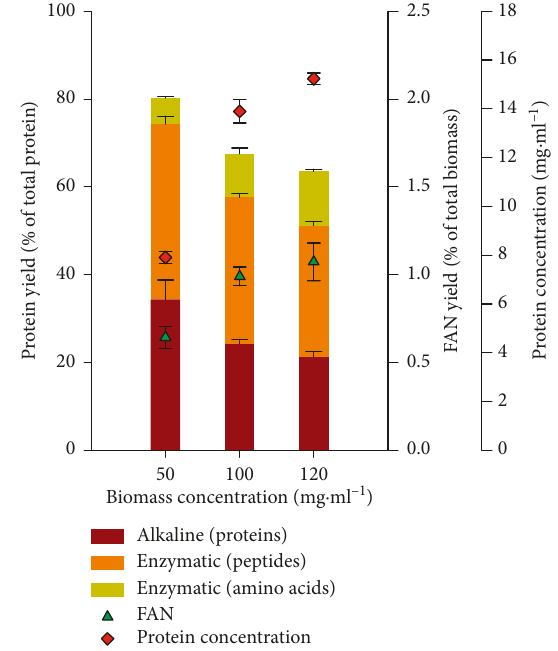
Figure 4: Effect of three biomass concentrations on the extraction yields of protein (% of total protein) and FAN (% of total biomass) and on the protein concentration in the final extract (mg differencing among first alkaline and second enzymatic